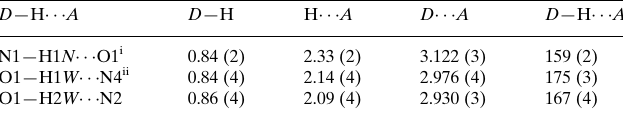
Hydrogen-bond geometry (A˚ , (cid:3)